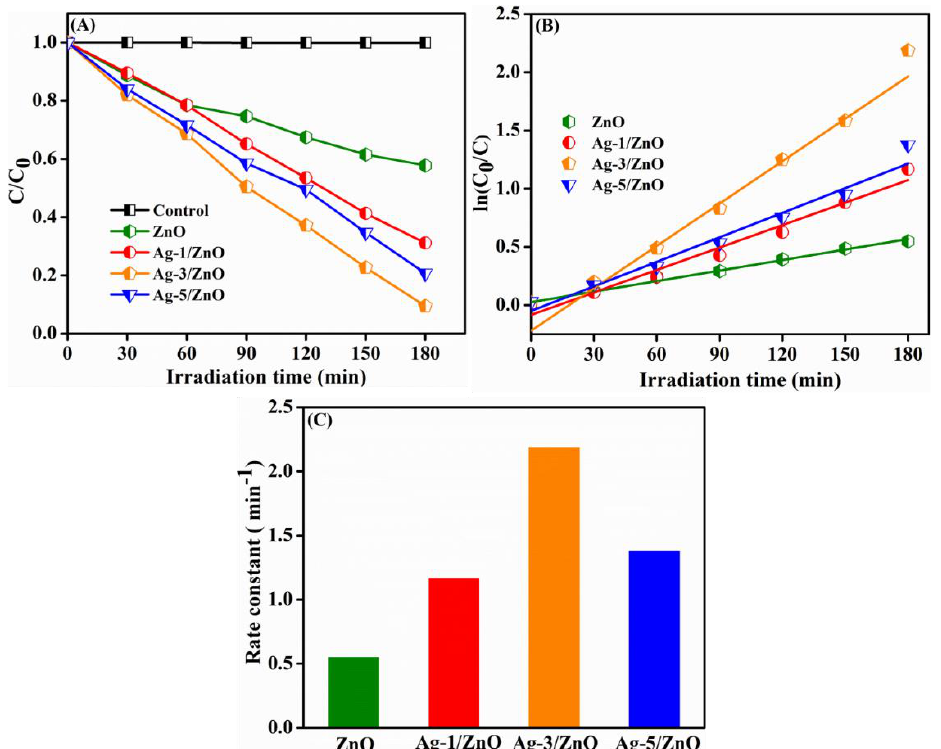
Figure 9. Photodegradation of RhB ( A ), corresponding pseudo-first-order kinetic plots ( B ), and rate constant plot ( C ) of ZnO and Ag/ZnO.